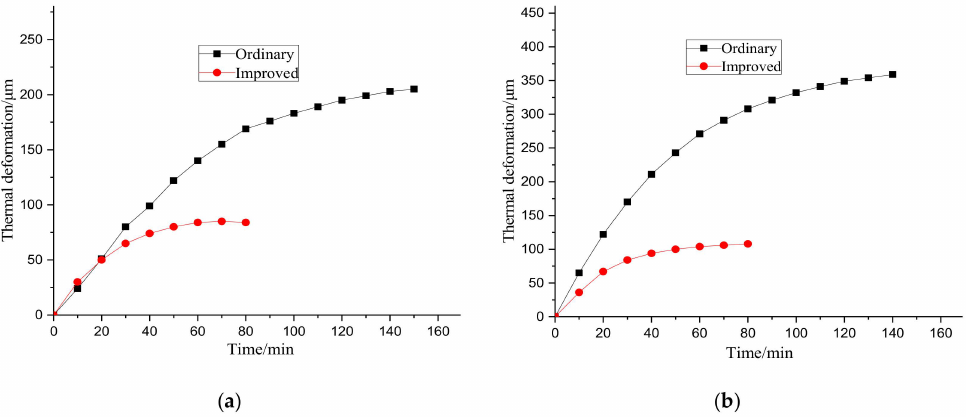
Figure 20. Deformation variation comparison. ( a ) 20 V; ( b ) 30